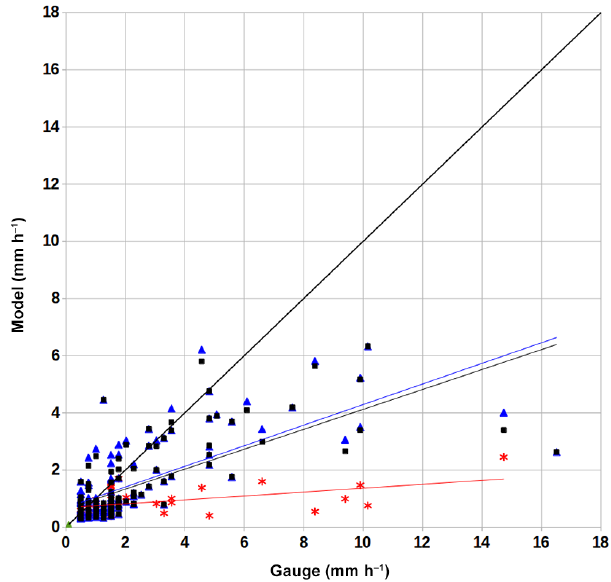
Figure 5. Verification of hourly accumulation values for Rad_Accum (black squares, with regression line equation y = 0 . 349 x + 0 . 638) and LDA_Accum (triangle, cross and circular markers), using three different methods to calculate the relationship profiles: average (blue triangles, y = 0 . 360 x + 0 . 691), third quartile (red circles, y = 0 . 417 x + 0 . 844) and the variable quartile (green crosses, y = 0 . 365 x + 0 . 710) accumulation estimates. The corre- sponding regression lines (see equations) are represented with same color as the markers for each method. Data are for the 4-day period in summer 2014, i.e., verification dataset (e). The best-fit curve (i.e., the 1:1 fit) is shown as a black solid line.